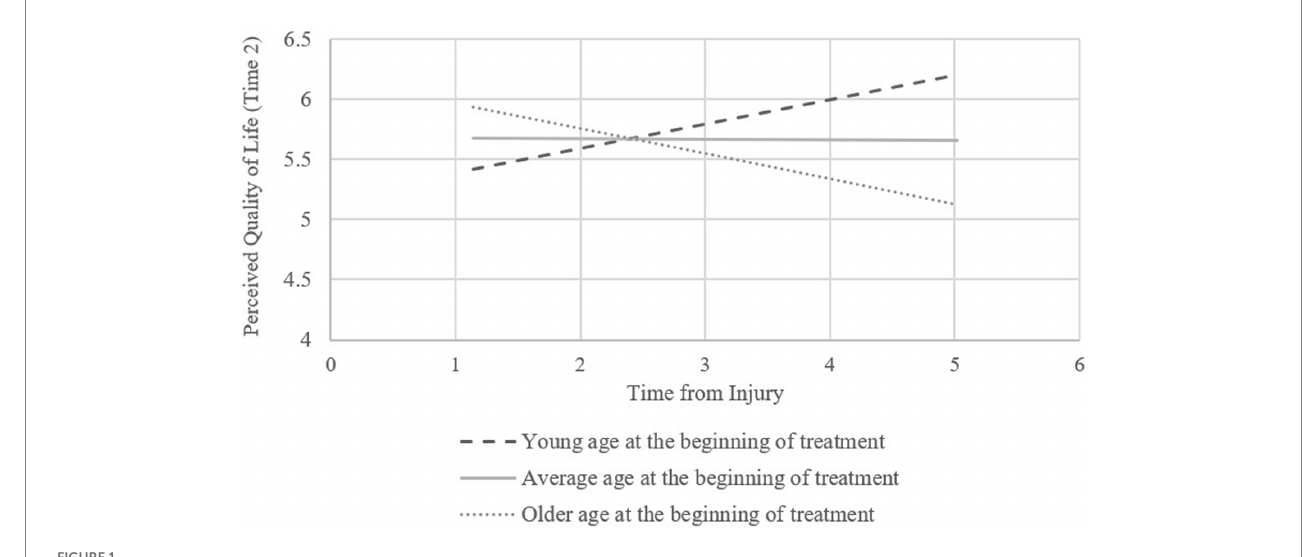
FIGURE 1 Simple effects of time from injury on perceived quality of